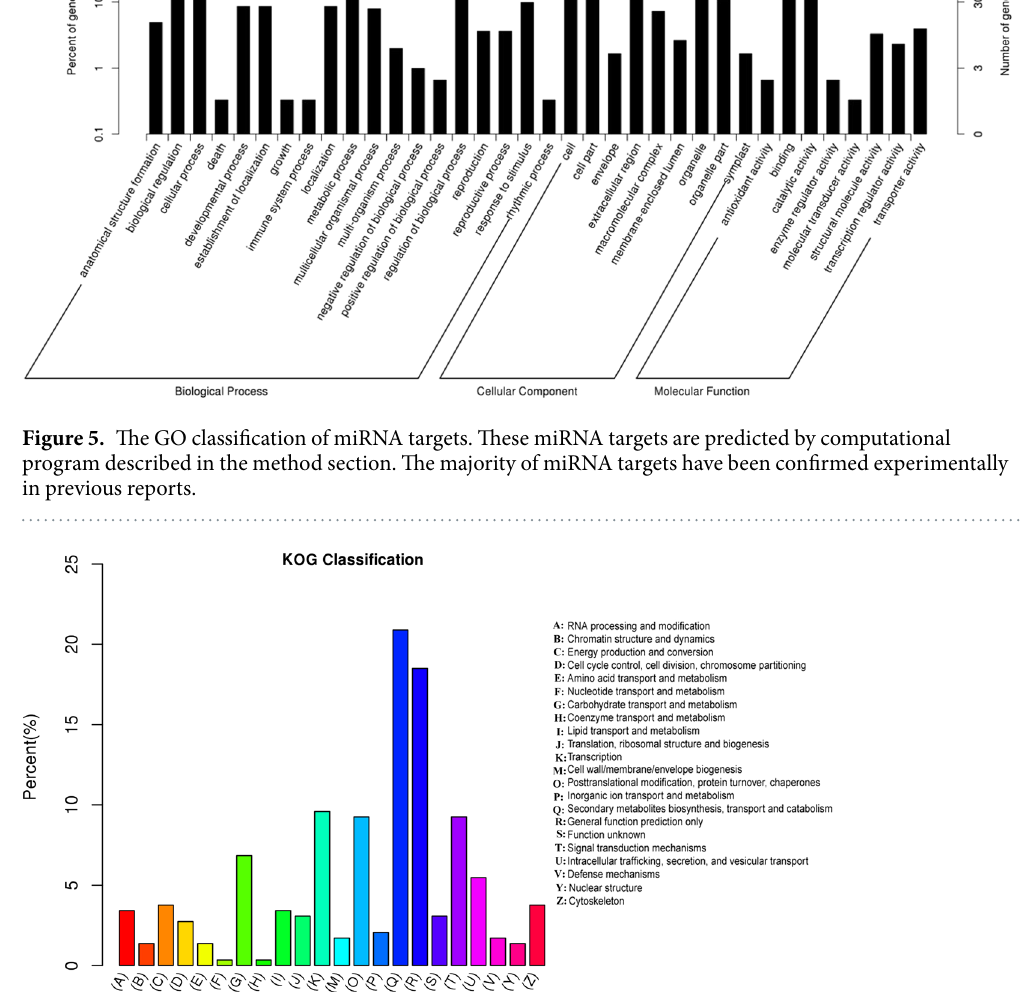
Figure 6. The KOG classification of miRNA targets. These miRNA targets are predicted by computational program described in the method section. The majority of miRNA targets have been confirmed experimentally in previous